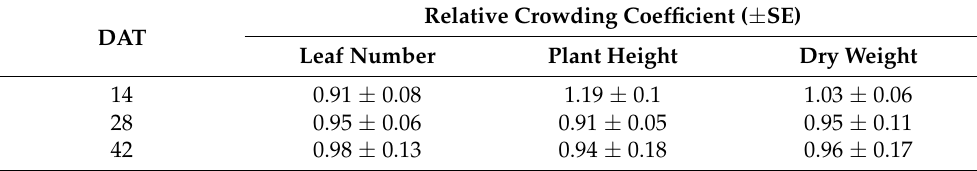
Table 3. Relative crowding coefficient values for leaf number, plant height, and dry weight at 14, 28, and 42 DAT.